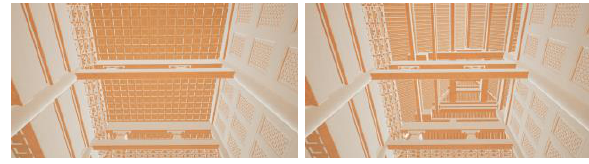
Figure 20. The ceiling of the temple Figure 21. The structure of the